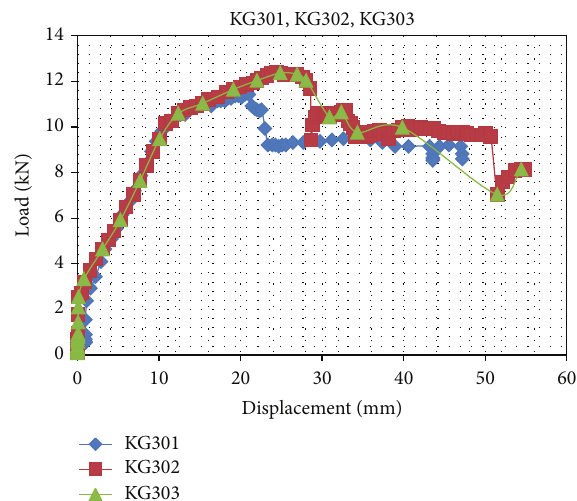
Figure 8: Load-displacement chart of the sample beam strength- ened with GFRP.